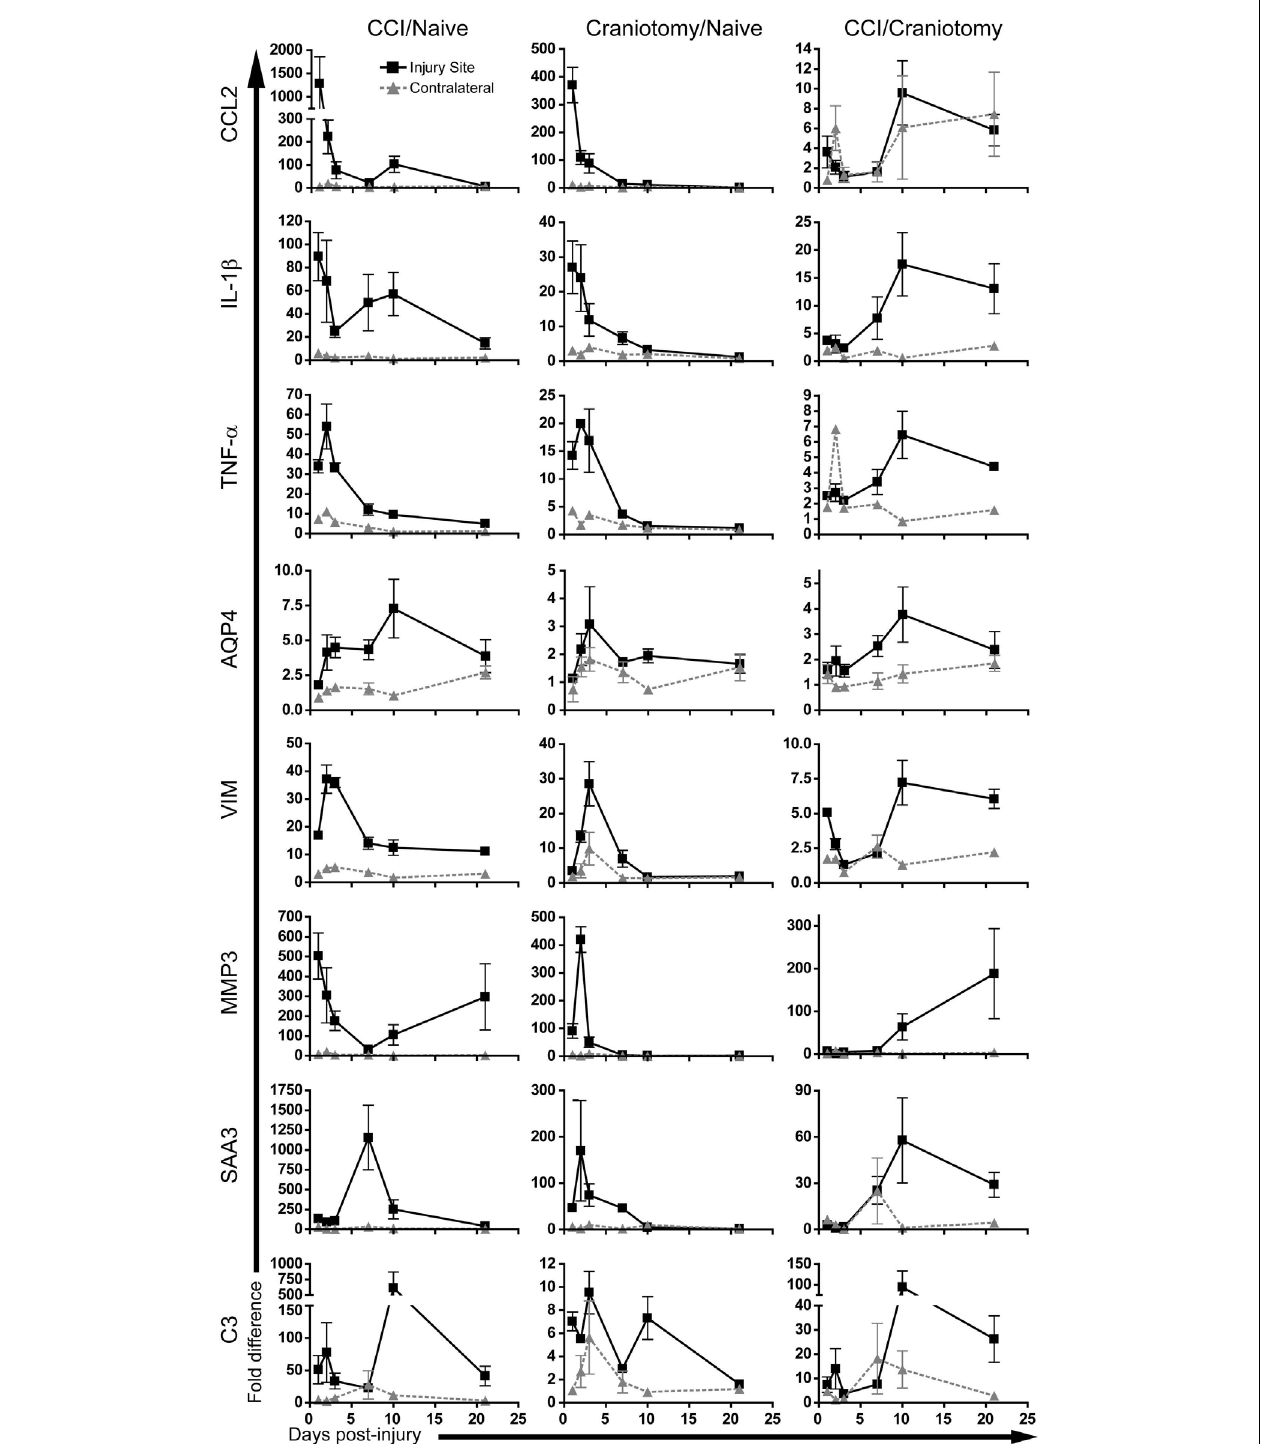
experimental group. Data are expressed as ratios of CCI/Naïve, Craniotomy/Naïve, and CCI/Craniotomy, as indicated, with the y -axis indicating fold-difference in gene expression. Note that the CCI/Craniotomy fold-difference at the injury site is greatest after day + 7 for all analyzed genes. Significant differences in mRNA levels in the CCI vs. Craniotomy groups are listed in Table 4 . Error bars are